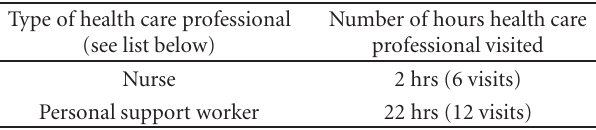
Type of health care